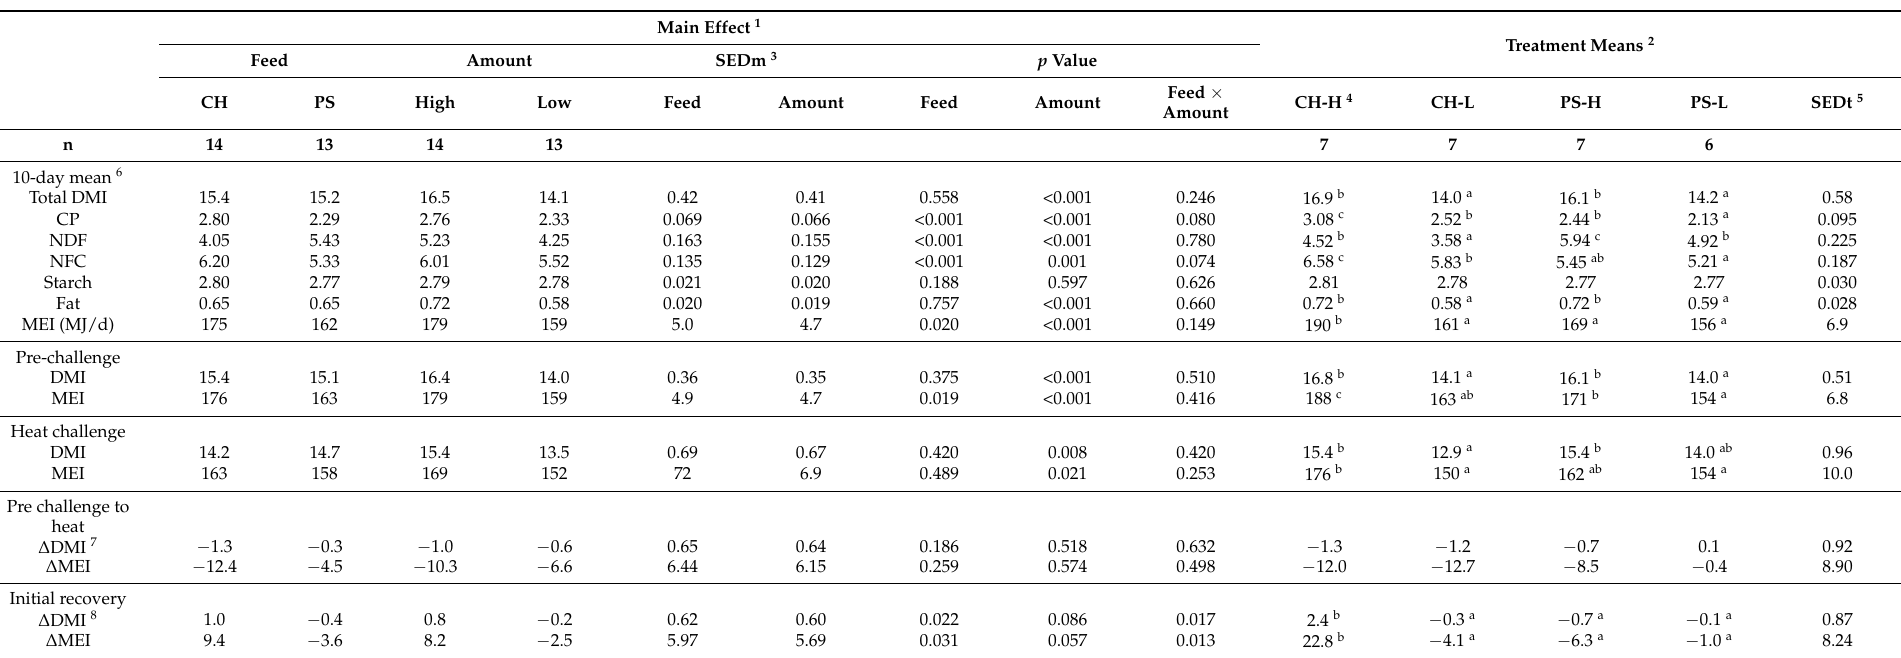
Table 5. Nutrient intake (kg/d unless specified) across the 10 days of measurement and the intake of dry matter (DMI, kg/d) and metabolizable energy (MEI, MJ/d) during selected periods of the